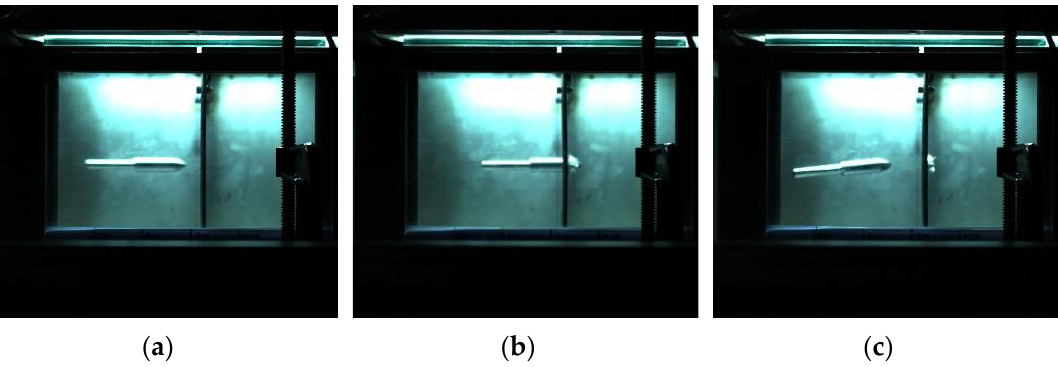
Figure 11. Experimental results for the launch speed of 42 m/s: ( a ) before penetration; ( b ) penetrating; ( c ) after collision.